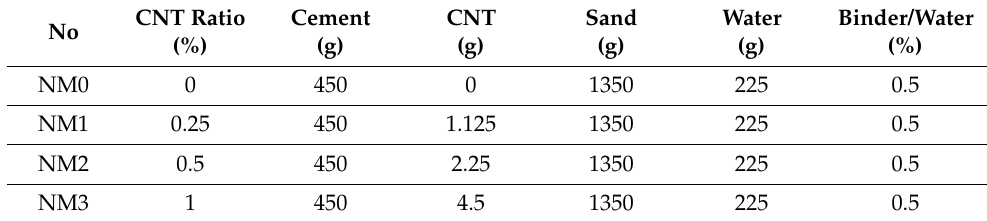
Table 4. Mixed proportions of composites.